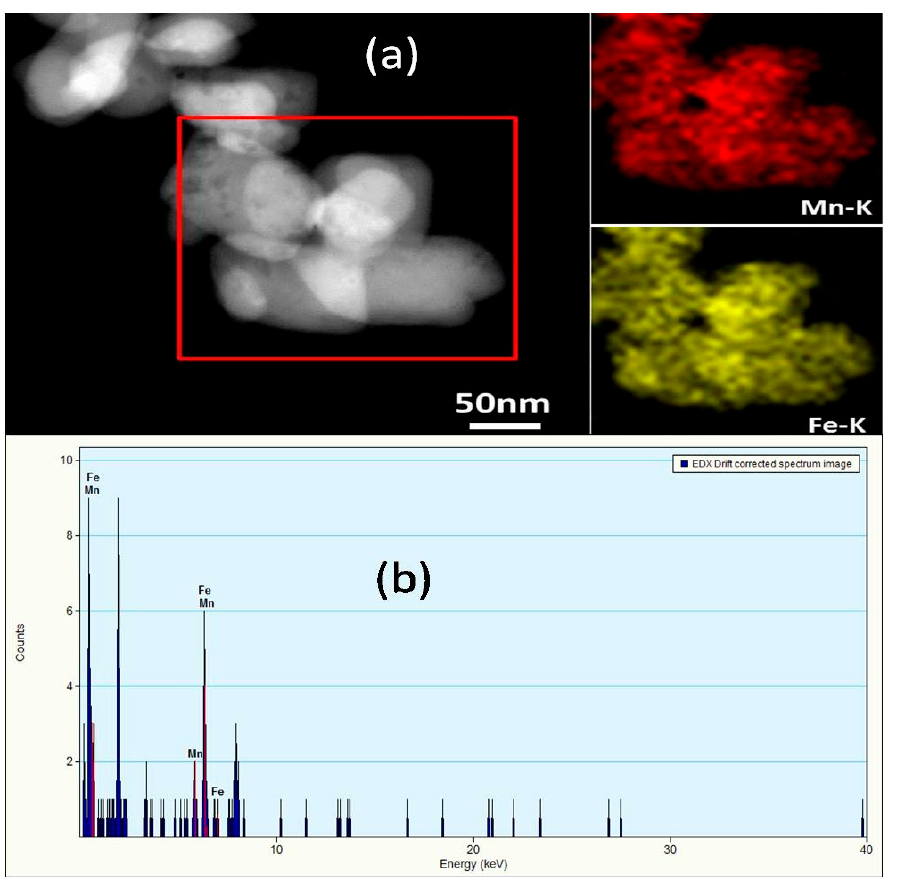
Figure 3. ( a ) Element distribution mappings of Mn and Fe and ( b ) EDX spectrum of LiMn 0.4 Fe 0.6 PO 4 .